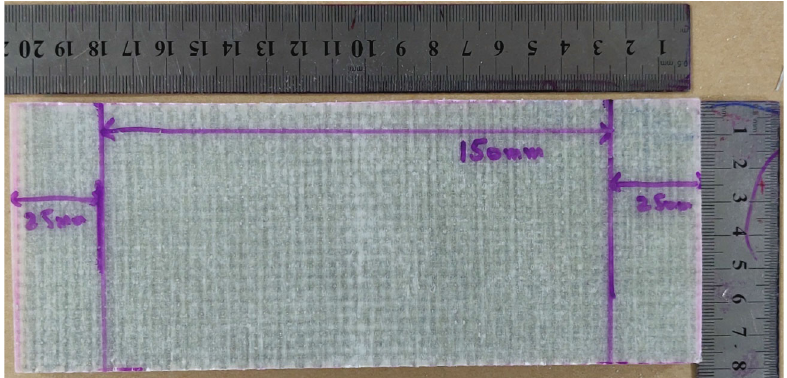
Figure 6: specimen prepared for fl exural testing (3-point